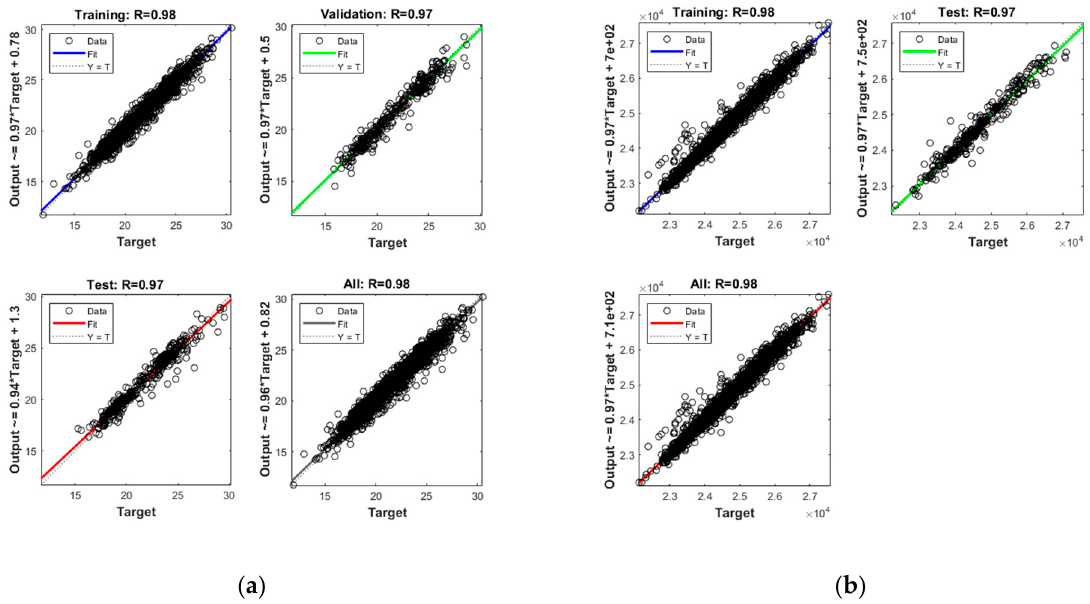
Figure 11. Neural network training results: ( a ) temperature module; ( b ) power demand module. Note how because of the use of the Bayesian Regularization algorithm for the power demand mod- ule, no correlation between validation samples and neural network results are presented, as full correlation (R = 1) is forced by the algorithm itself only for that category of samples.